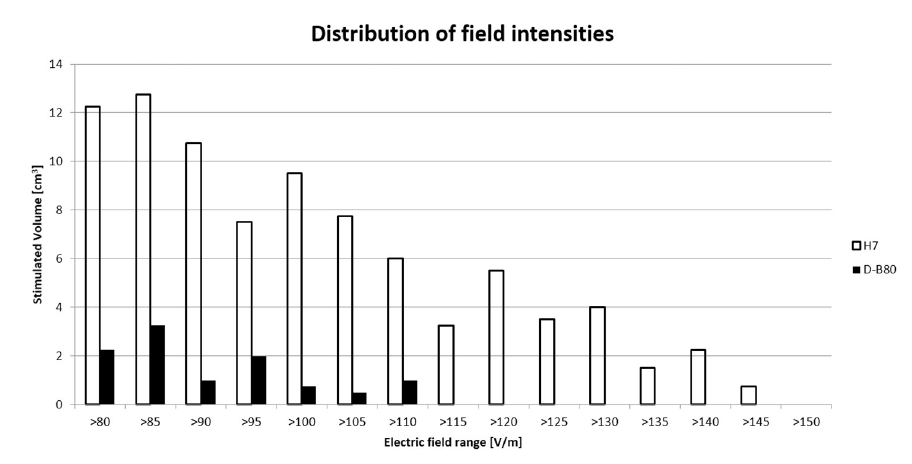
Fig 2. Distribution of values of EF intensity. Histograms of distribution of the volume in cm 3 according to the induced electric field range within the brain for the D–B80 and H7. Field columns are in bins of 5 V/m. The distribution of field values within the brain is significantly different between the coils (p = 0.002, Wilcoxon matched– pairs test).